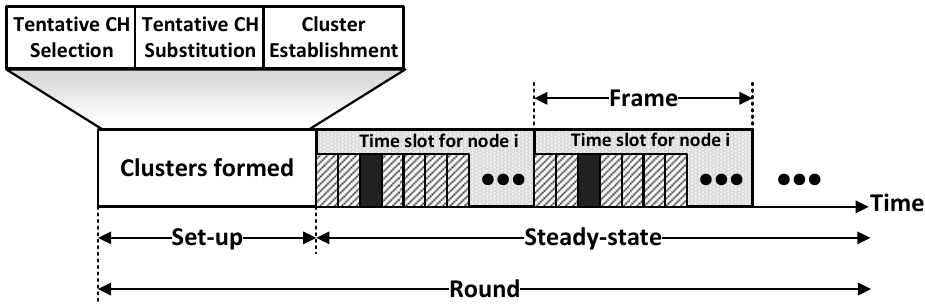
Figure 2. A timeline showing the operations of DCE: to form a cluster, the network goes through three main operations in the set-up stage, i.e., tentative CH selection, tentative CH substitution and cluster establishment; in the steady-state stage where data transmission is performed, the operation is divided into frames and each node transmits its data in assigned time slot.